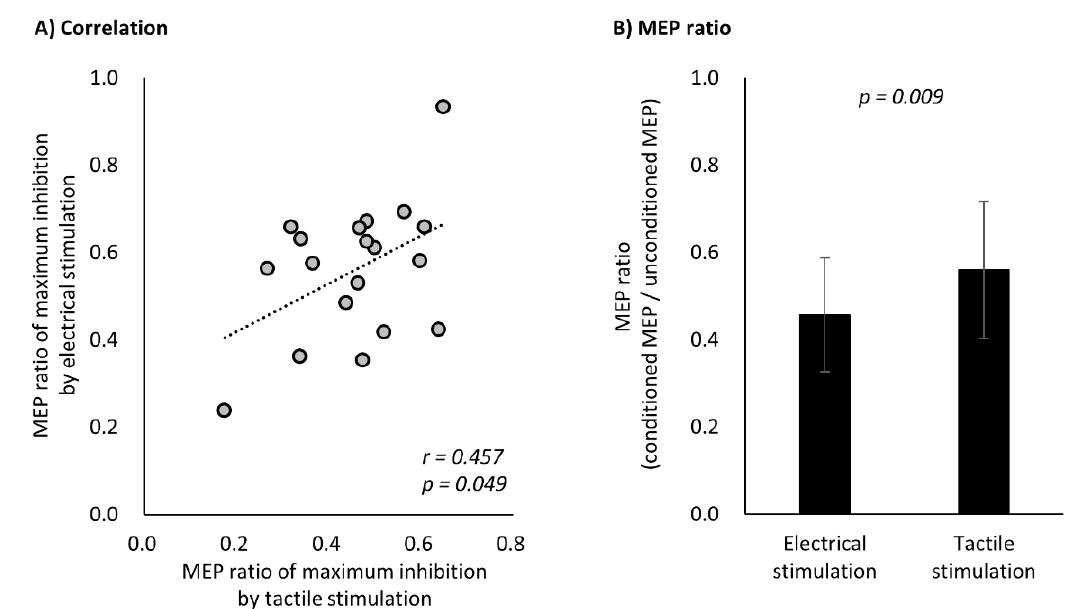
Figure 3. Correlation and comparison of the motor evoked potential (MEP) ratio after each conditioning stimulus. ( A ) Pearson’s correlation analysis revealed a significant correlation between the maximum inhibitory effects of electrical stimulation and mechanical tactile stimulation in each participant. ( B ) The inhibitory effects of MEP after electrical stimulation were significantly higher than those after mechanical tactile stimulation. Data are expressed as the mean ± standard error of the mean (SEM).